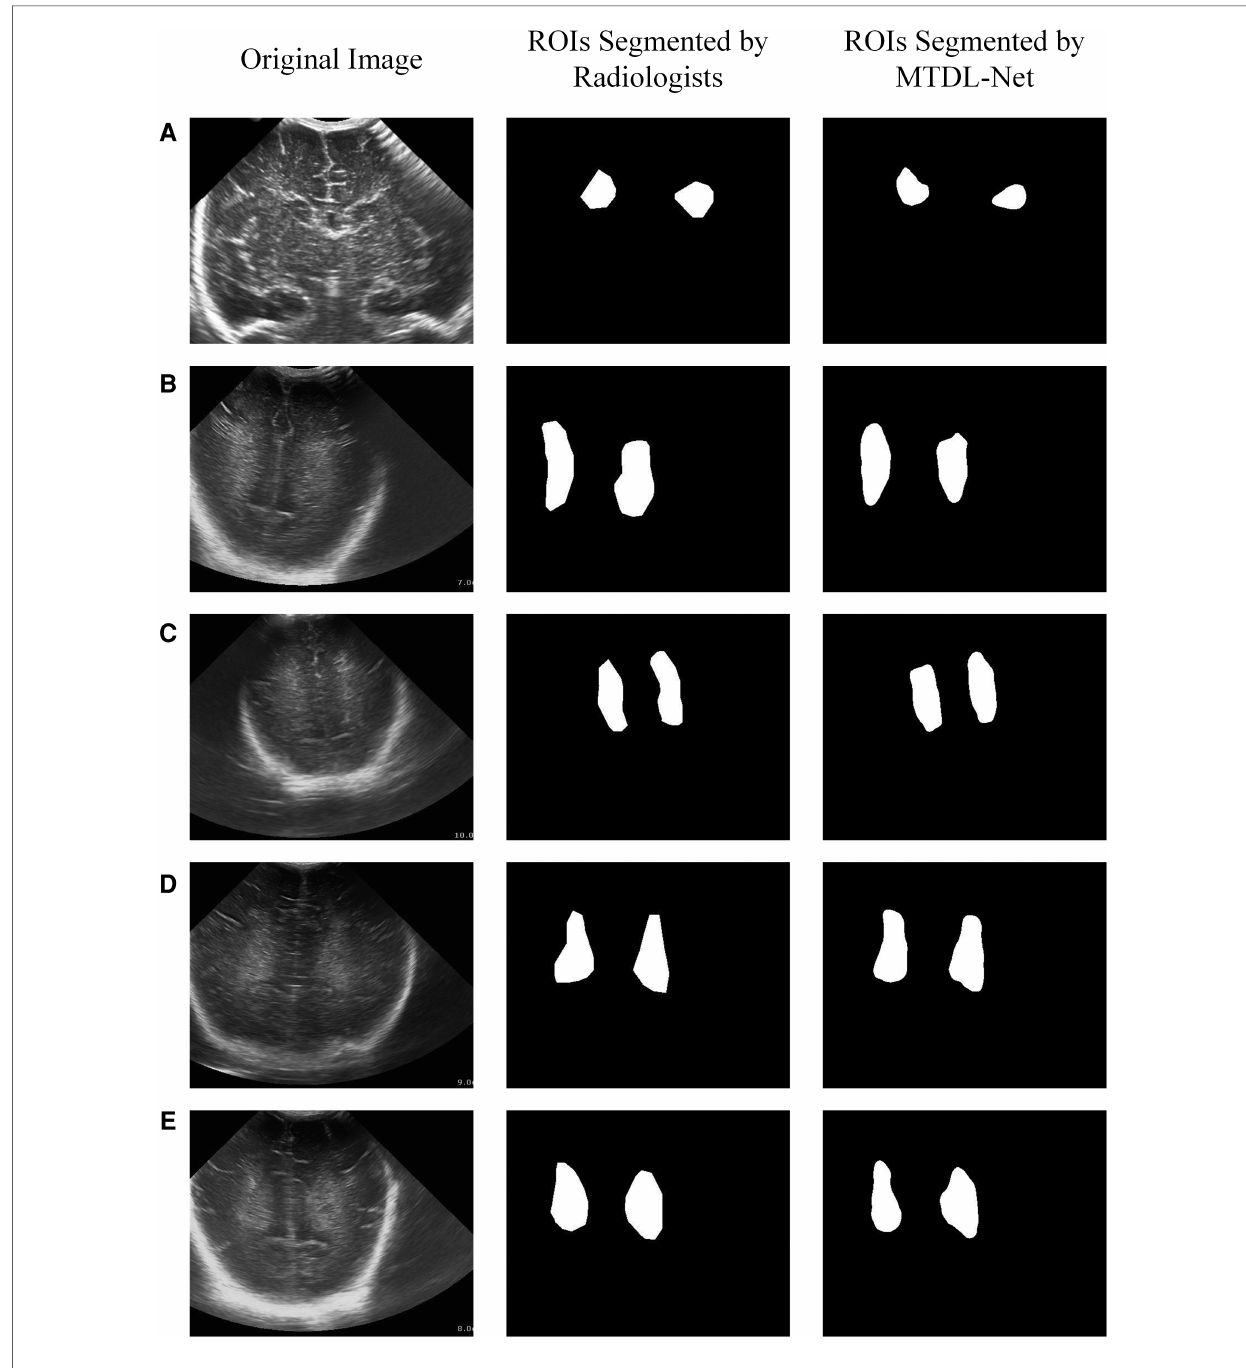
FIGURE 9 White matter ROIs segmented by MTDL-Net.